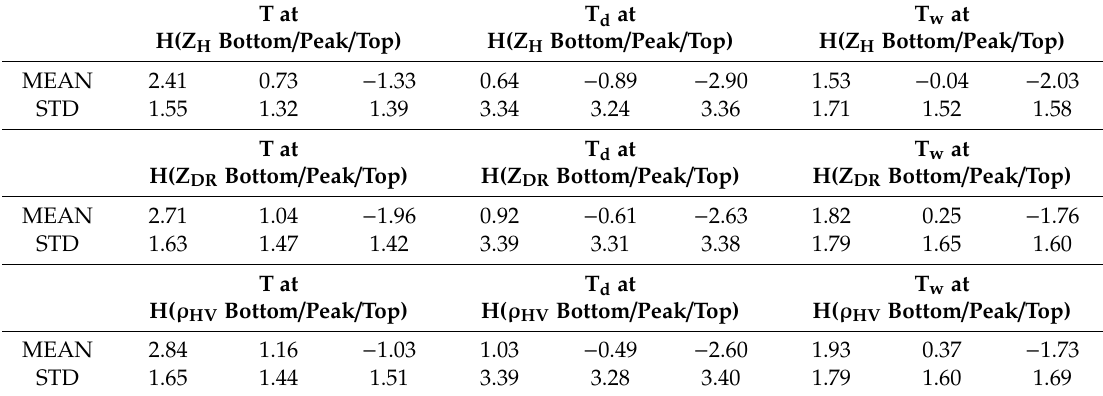
Figure 10. Two-dimensional frequency distributions between ( a ) H(Z H Peak) and H(T = 0 °C) and between ( b ) H(Z H Peak) and H(T w = 0 °C). Table 4. Mean and standard deviation (STD) of temperature (T), dew point temperature (T d ), and wet-bulb temperature (T w ) at the top, peak, and bottom of the